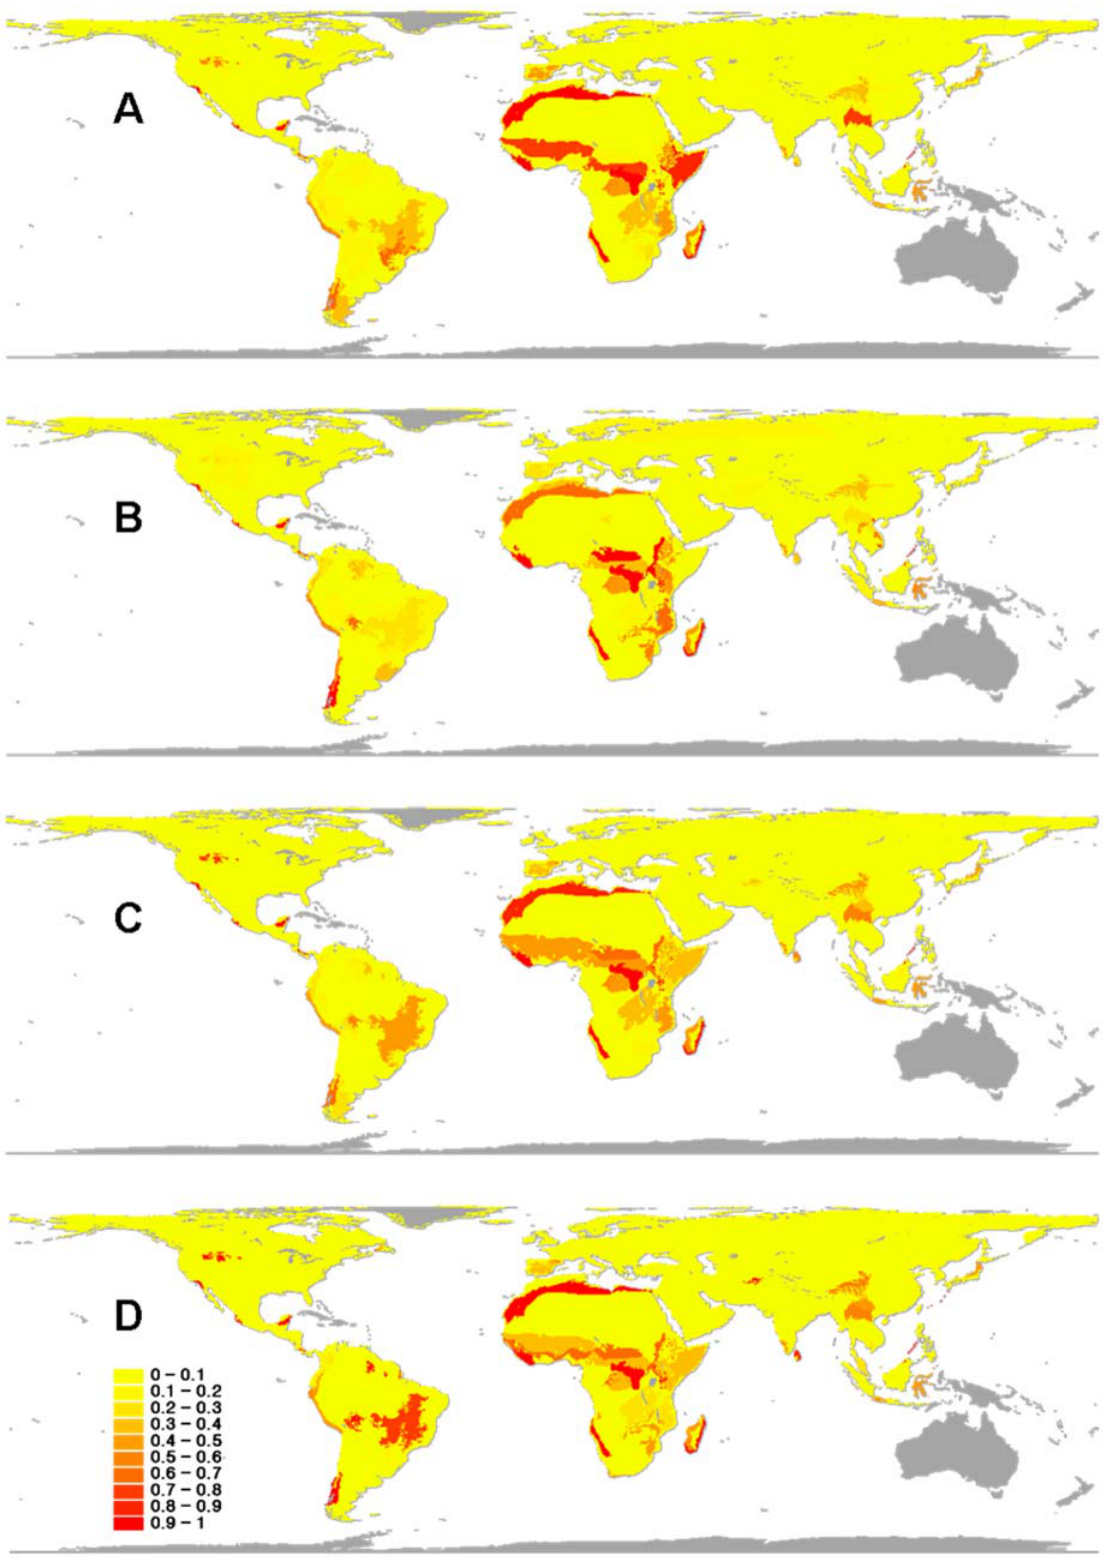
Figure 2. Irreplaceability patterns in the four different conservation planning scenarios. Spatial patterns of irreplaceability in the four different conservation planning scenarios: minimum ecoregion (A), cost-effective (B), highly vulnerable (C), and a combined scenario (D) that considered both species vulnerability (estimated from their biological traits) and economic costs. Irreplaceability values are the frequency of ecoregions in 100 optimal solutions for the entire 236 species of carnivores found in 661 ecoregions of the world. Values range from yellow (low) to red (high); countries in grey have no native carnivores.